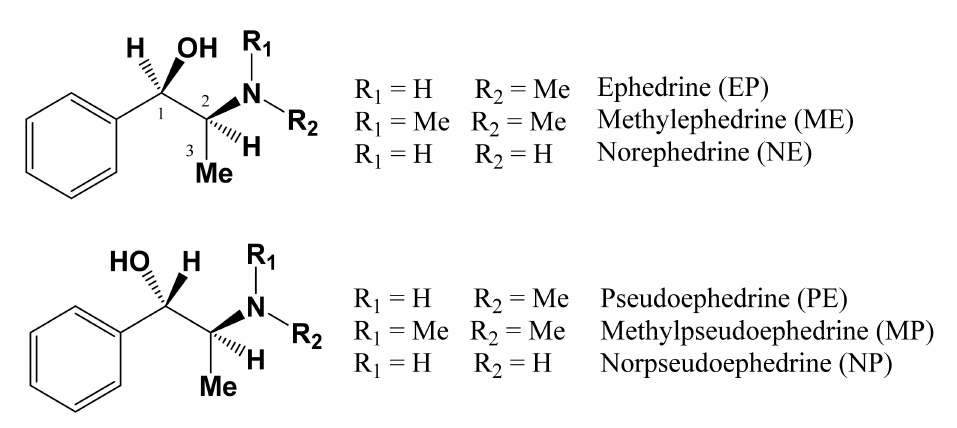
Figure 1. Structures of the active alkaloids in Ephedra